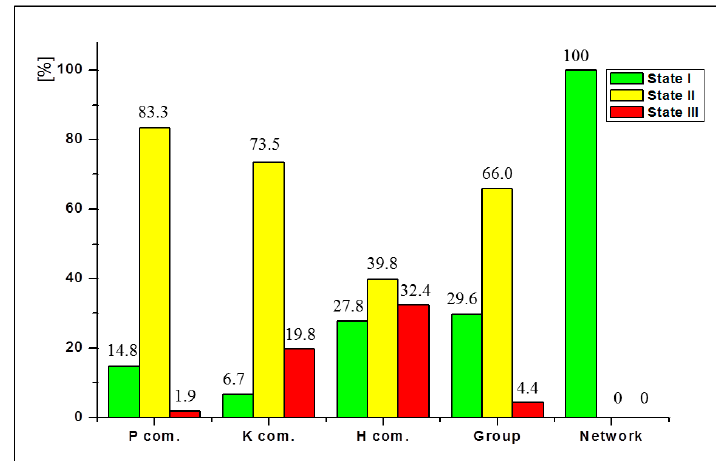
Figure 17. Analysis of the frequency deviation range.